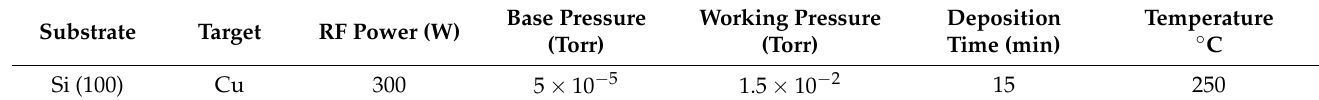
Table 1. Details of the Cu layer deposition conditions.